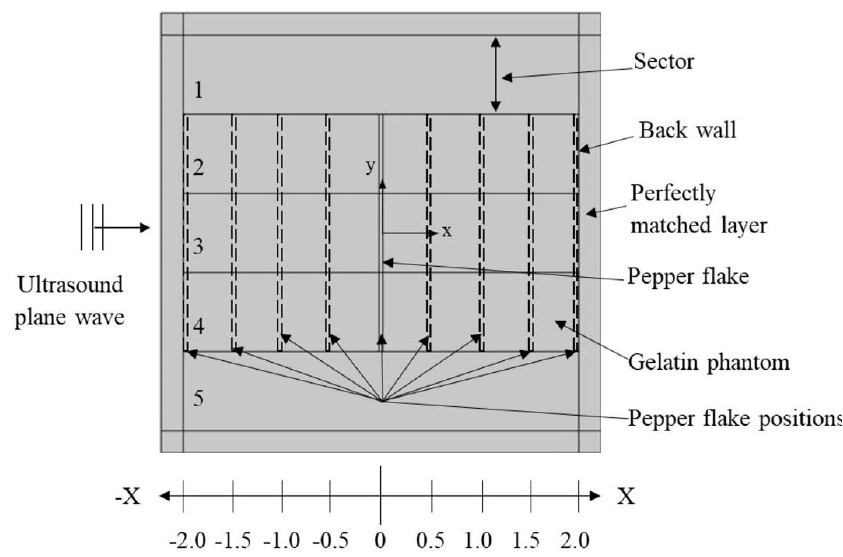
Figure 7. Pepper flake positions.